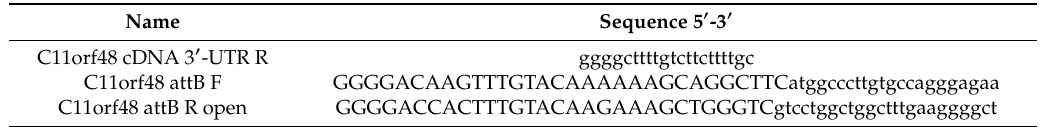
Table 2. Name and sequence of PCR primers used for LBHD1 cloning.